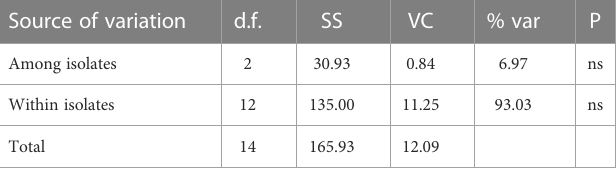
TABLE 6 Analysis of molecular variance (AMOVA) of Neo fl abelliforma dubium n. sp. based on Rpb1 gene.